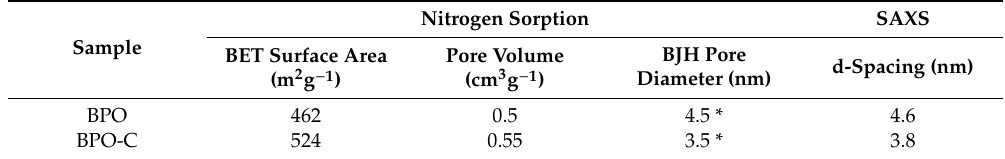
Table 1. Nitrogen sorption and SAXS data.